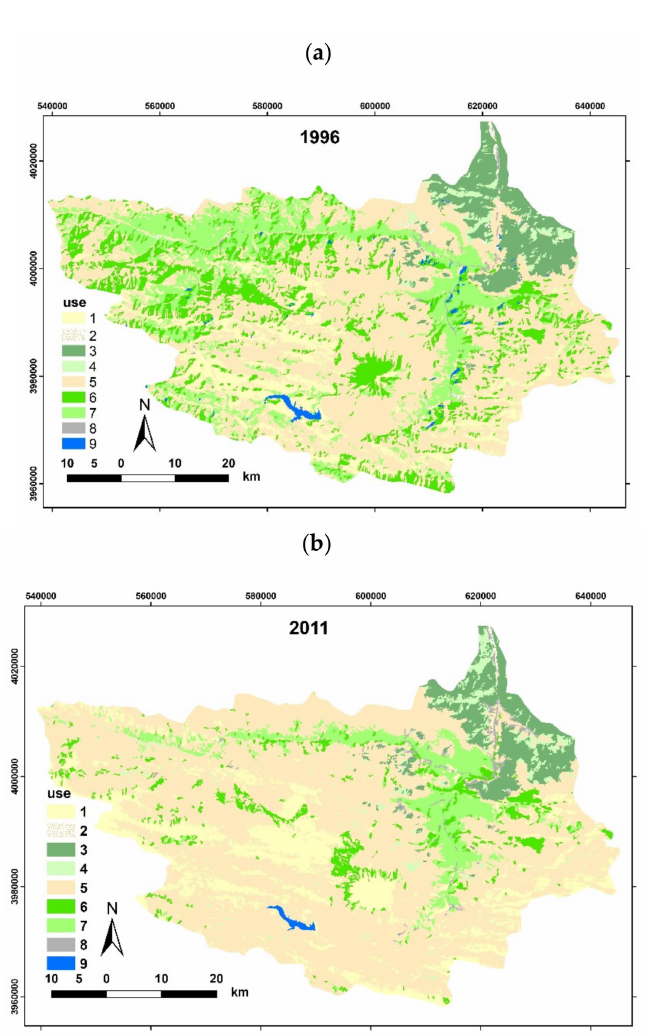
Figure 2. Land-use map of 1996 ( a ) and 2011 ( b ). The land-use classes are 1, bare land; 2, irrigated farming; 3, dense forests; 4, sparse forests and horticulture; 5, rangeland and dry farming; 6, first- grade range; 7, second-grade range; 8, residential lands; 9,